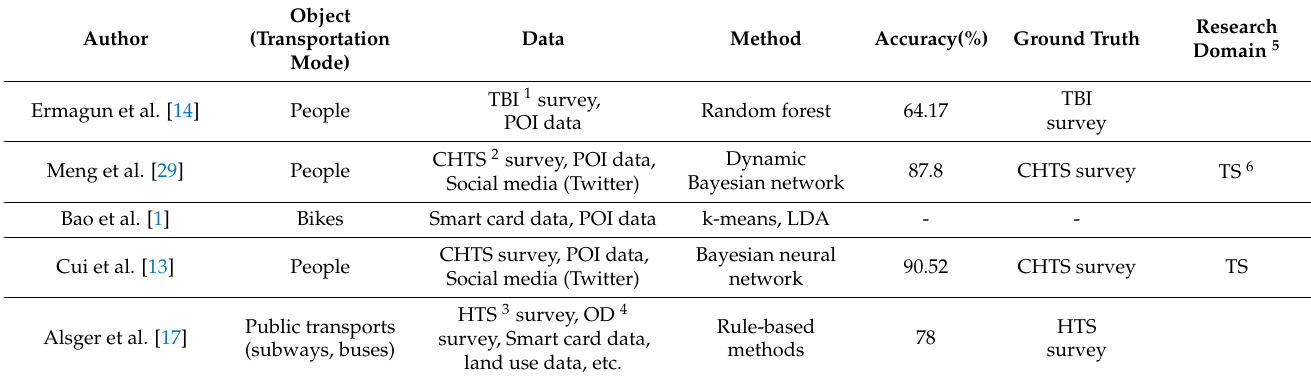
Table 1. Previous studies related to trip purpose